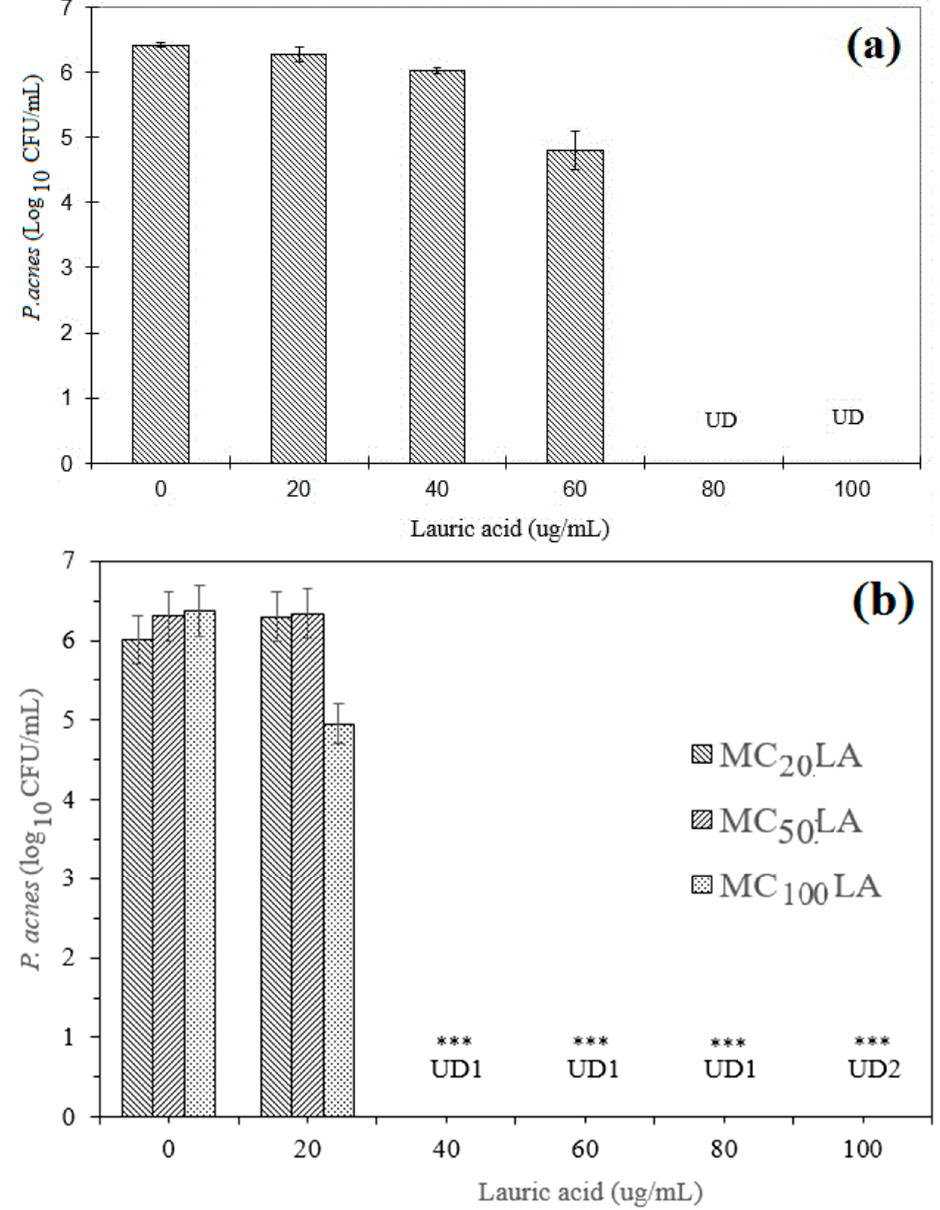
Figure 7. The minimum bactericidal concentration (MBC) assay. UD: no colonies on a Noble agar plate. UD1: there were no colonies for MC 20 LA, MC 50 LA, and MC 100 LA. UD2: there were no colonies for MC 20 LA and MC 50 LA; 100 μ g/mL MC 100 LA was not tested; ( a ) LA dissolved in 5% DMSO or ( b ) LA-loaded micelles co-cultured with 10 7 CFU/mL of P. acnes in reinforced clostridial medium (RCM) medium for 5 h and then spotted on Noble agar plate for 96 h, followed by colony counting; *** indicates significant difference compared to blank micelles made of respective copolymer by student’s t -test ( n = 3).